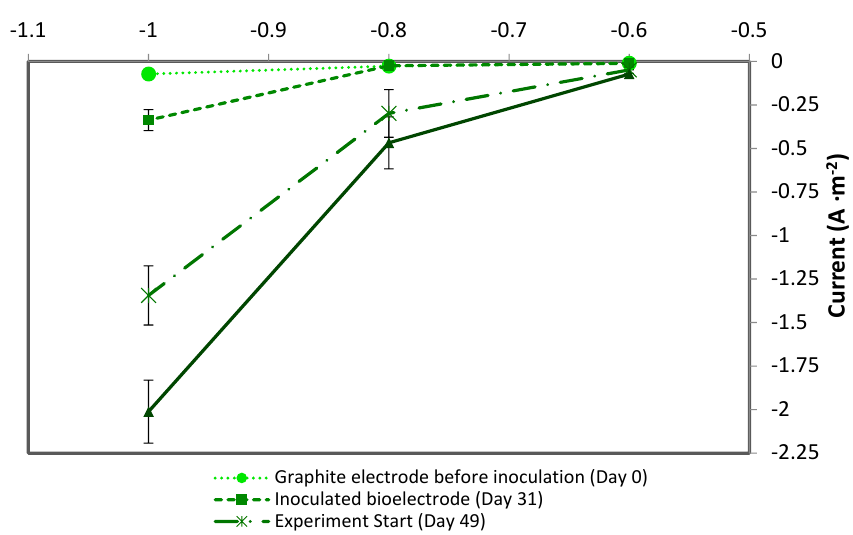
Figure 2. Evolution of polarization curve currents along the experiment.